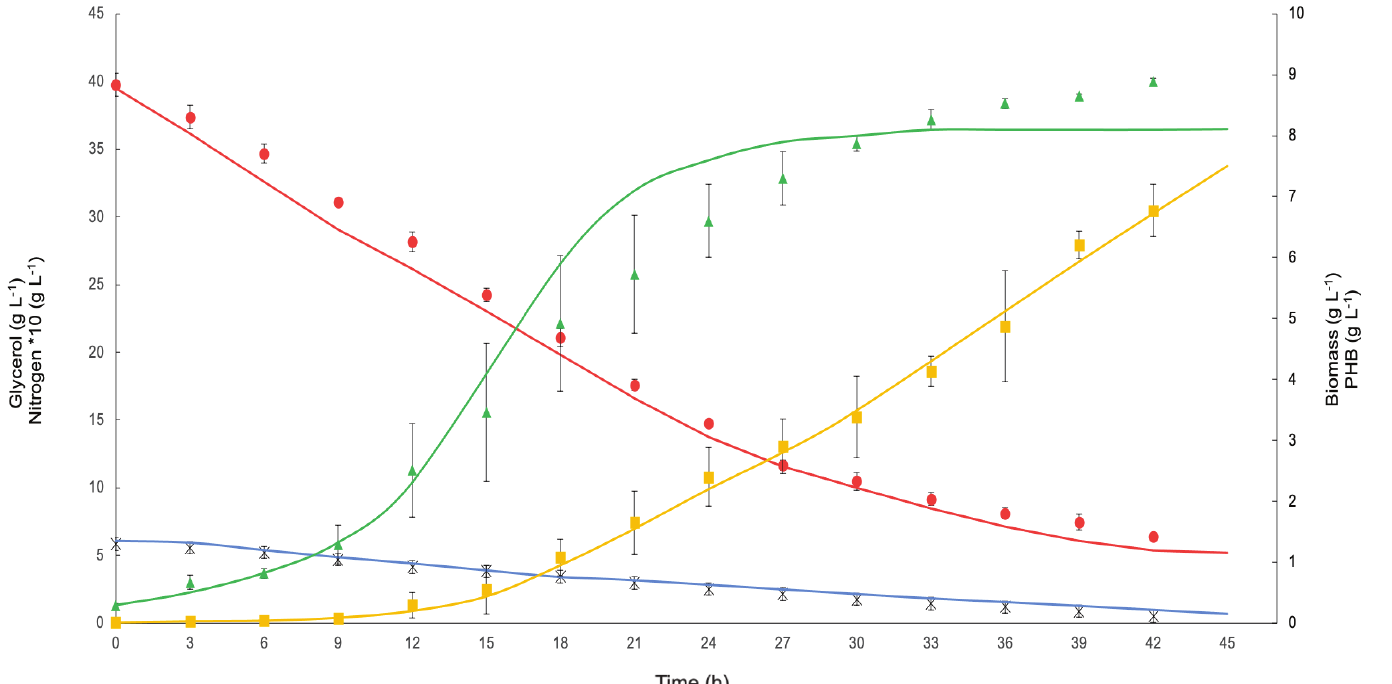
Fig. 4 – Comparison of model simulations (smooth lines) and experimental values (data points) of batch fermentation kinetics of C. necator. Data points (● Glycerol, × Nitrogen, ■ PHB, ▲ Biomass) represent the average values of the samples